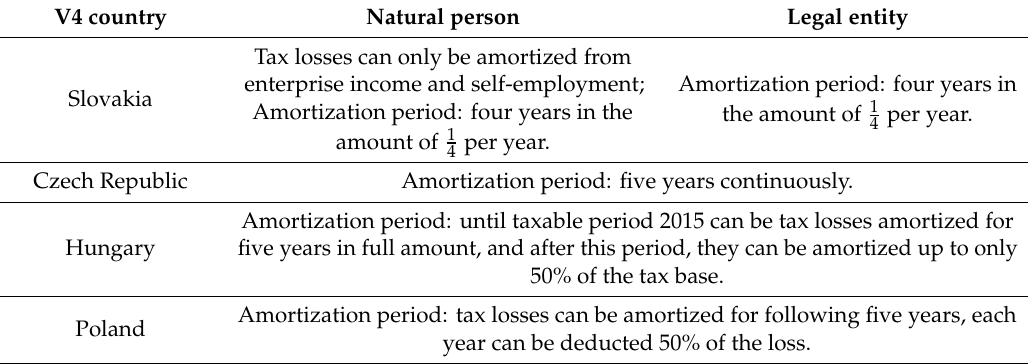
Table 1. Tax loss amortization in business entities of the V4